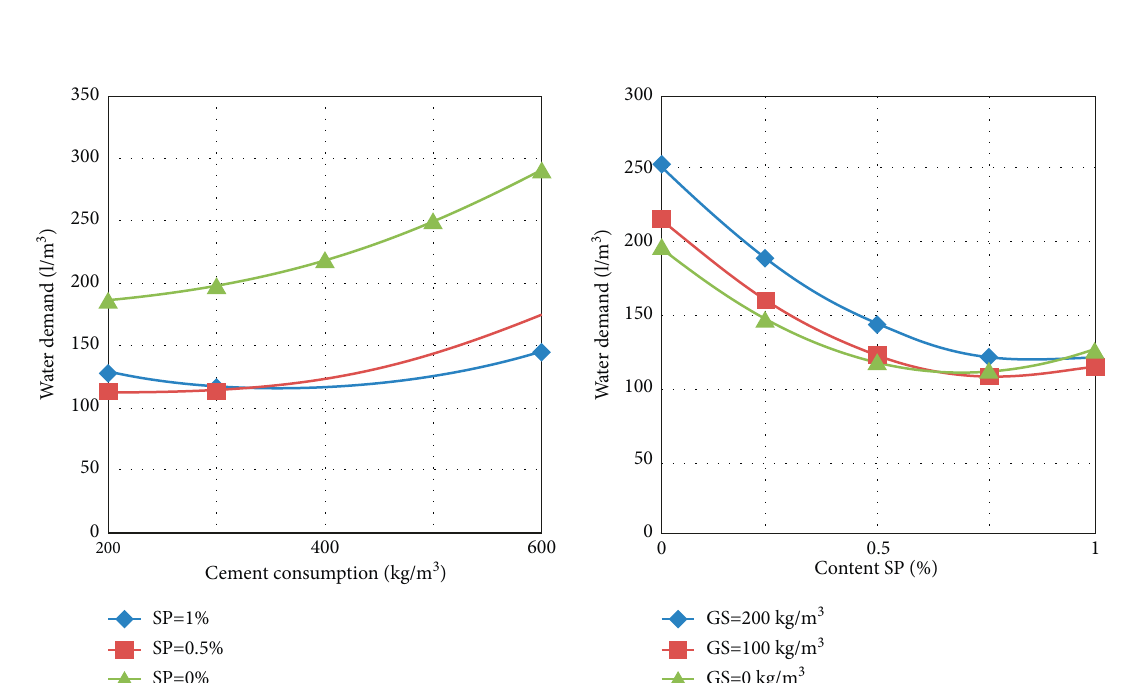
Figure 1: Influence of cement and superplasticizer consumption on SCC mixtures water demand.